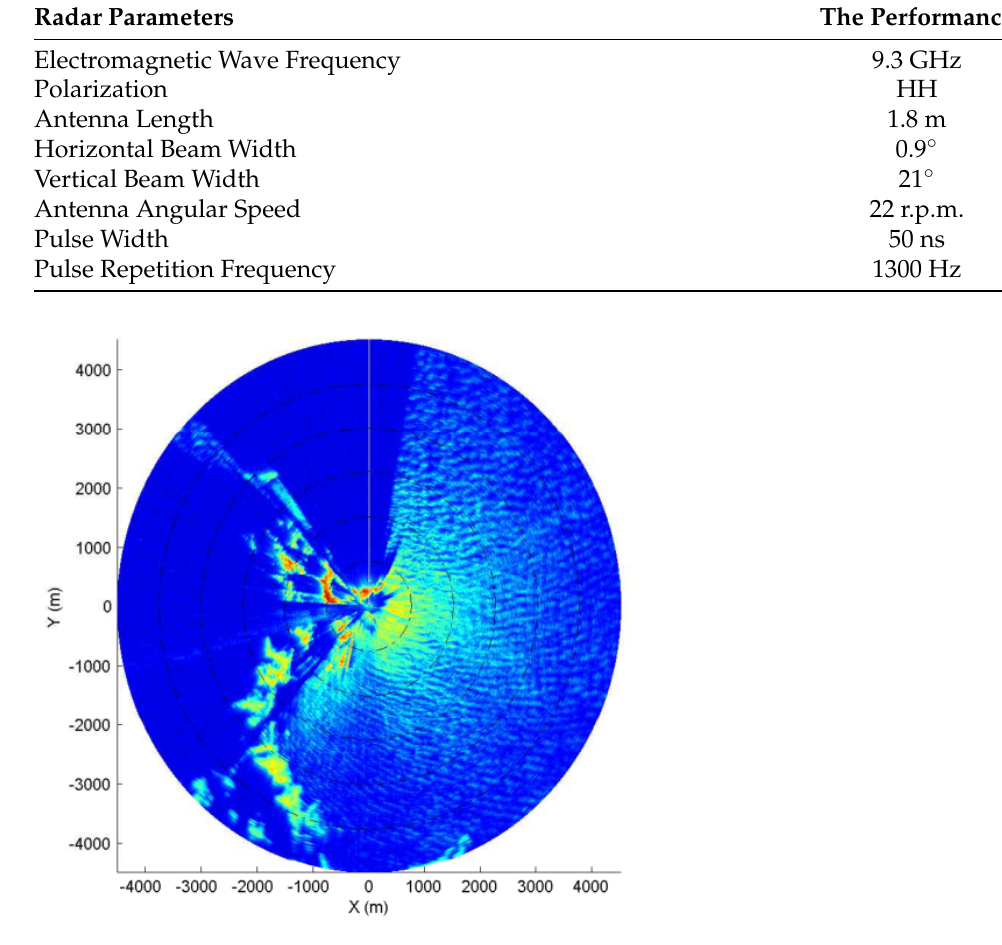
Figure 4. The acquired shore-based marine radar